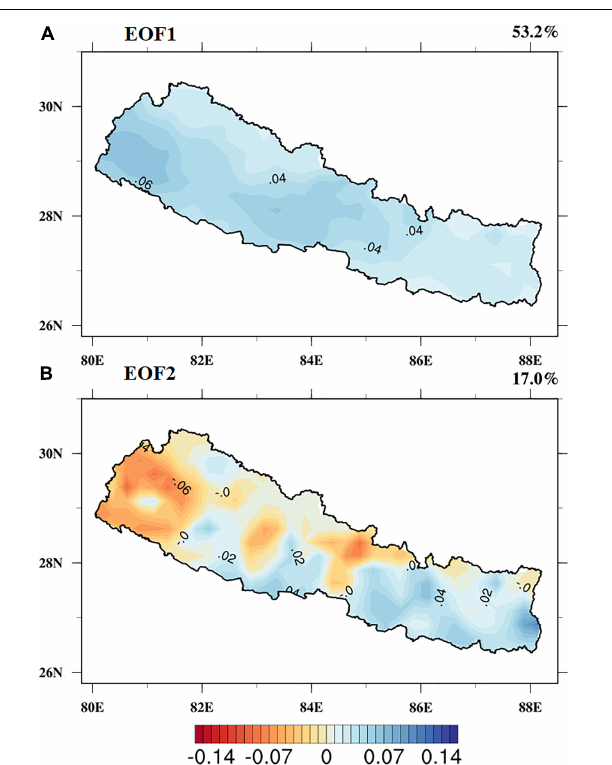
FIGURE 4 | (A) The first dominant mode of variability (EOF1) explains 53.2% of the total variance of the mean winter precipitation and (B) the second dominant mode of variability (EOF2) explains 17% of the total variance of the mean winter precipitation over Nepal, based on APHRODITE data